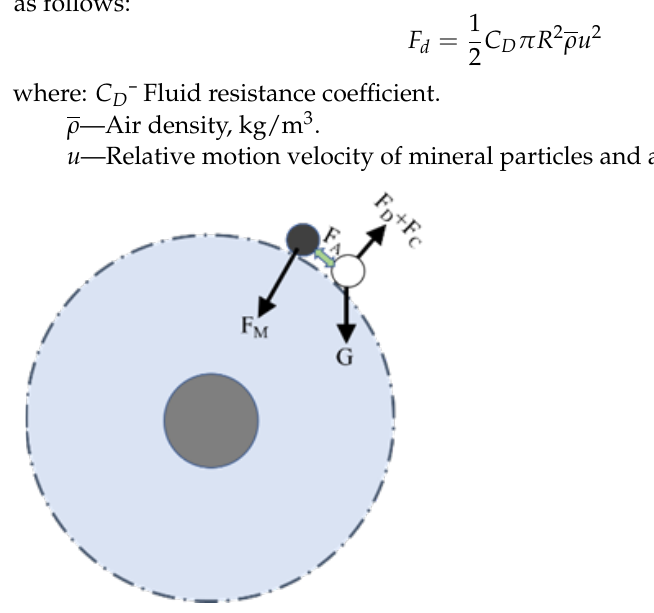
Figure 15. Dominant forces of the MSOFF during its operation.